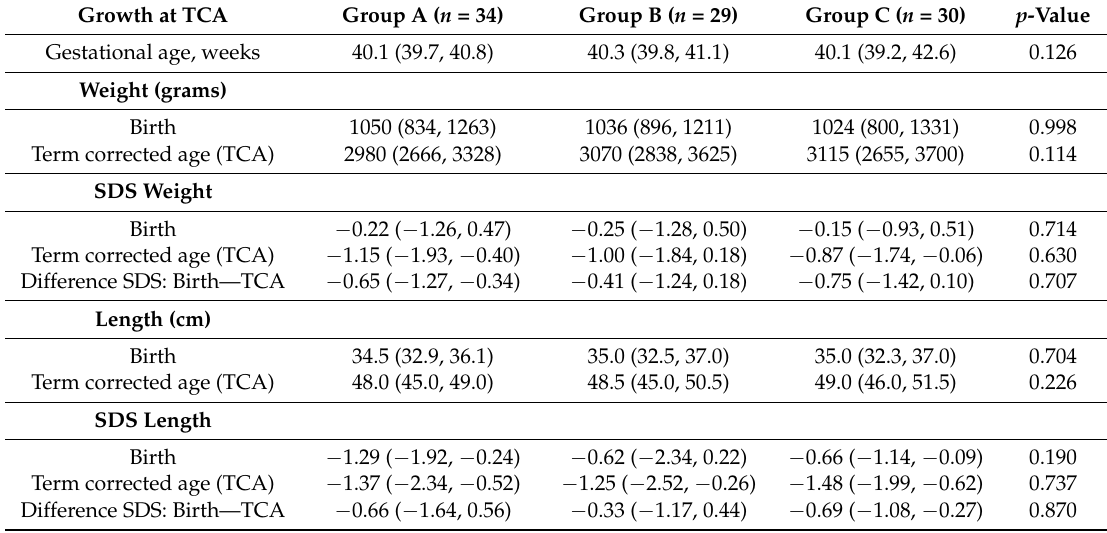
Table 3. Outcome of anthropometry at term corrected